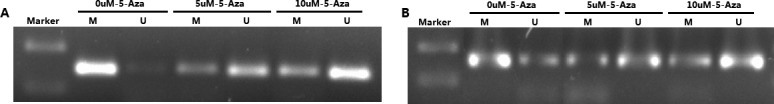
Detection of the methylation status in the promoter regions of SALL3 in SiHa(A) and HeLa(B) cells after treated with 5-Aza.(M: methylated; U: unmethylated).